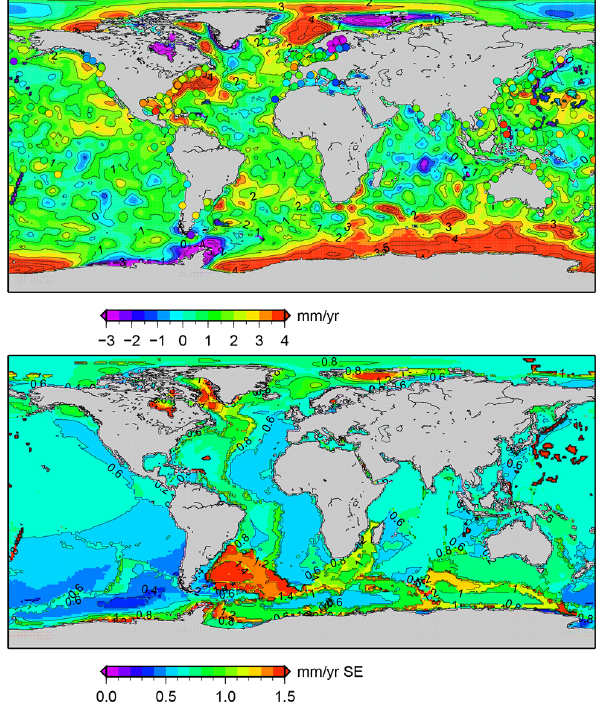
Figure 4. Upper panel: net trend in sea-level change (mmyr − 1 ) over the period 1961–2003, including all the contributions as shown in Fig. 2. Tide gauge trends in filled circles. Lower panel: uncertain- ties (1 σ ) in the net sea-level change trend (mmyr − 1